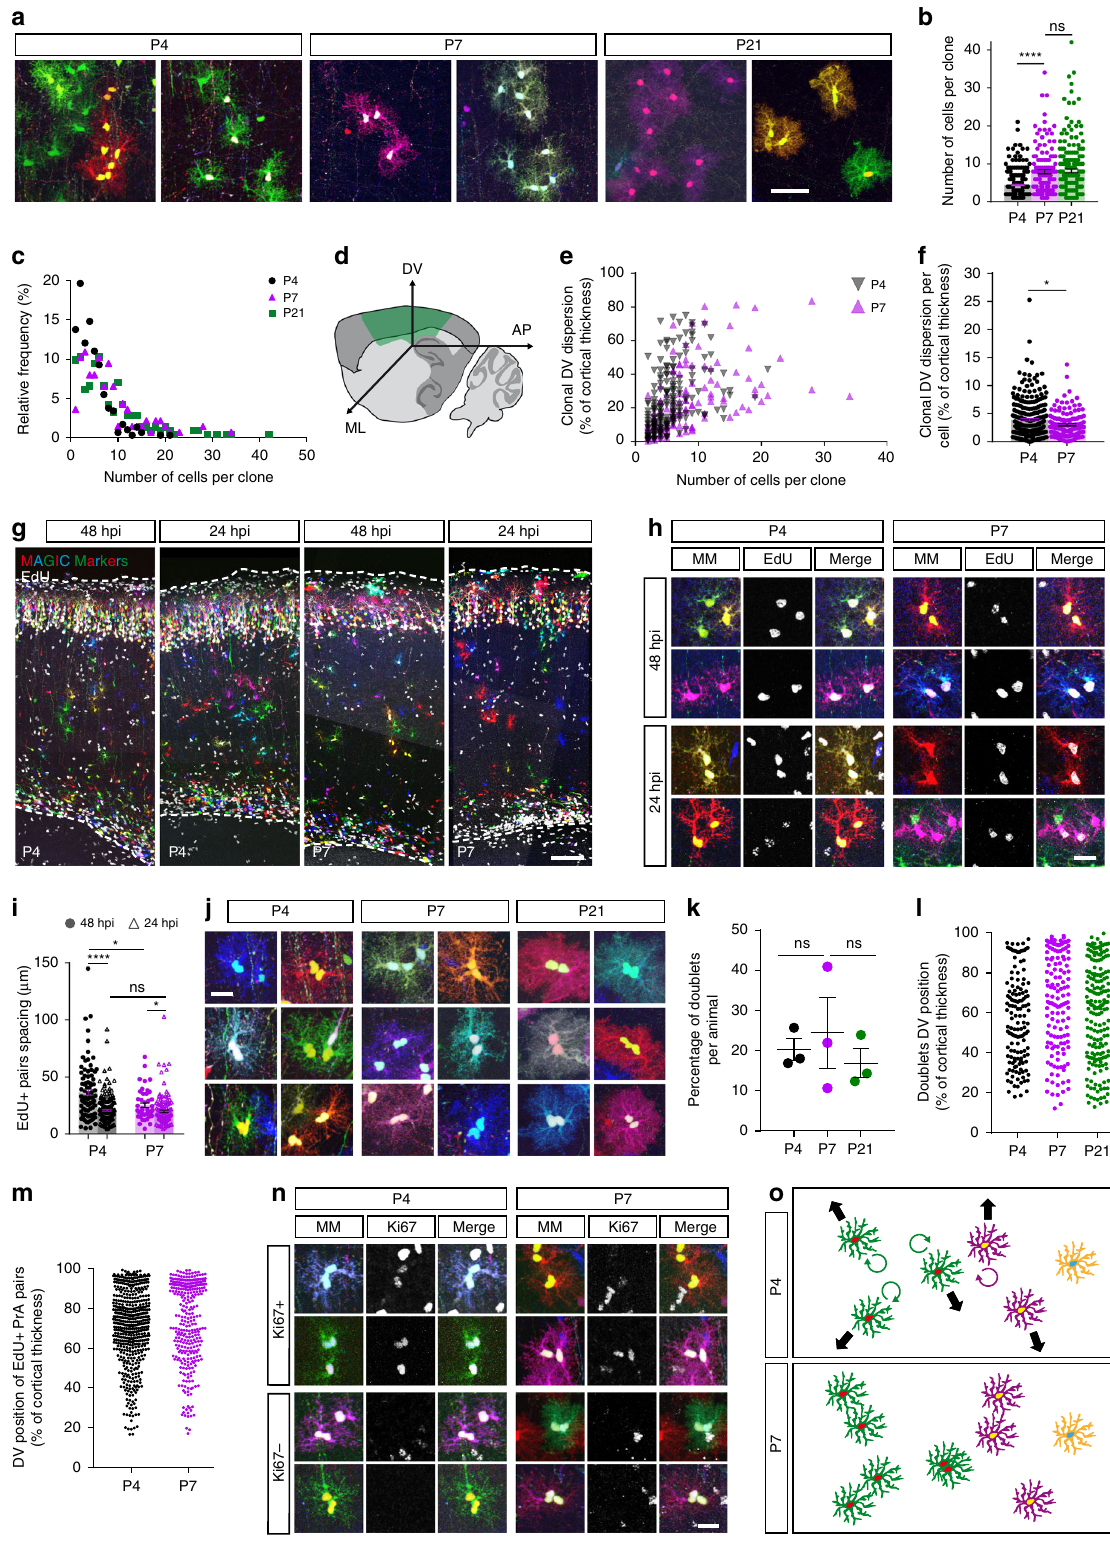
(Fig. 5i). Thus a signi fi cant proportion of cortical astrocytes originate from postnatally delaminating cells and like those that emigrate at embryonic stages from the ventricular niche, they disseminate into the cortical parenchyma and give rise to NATURE COMMUNICATIONS| (2019) 10:4884